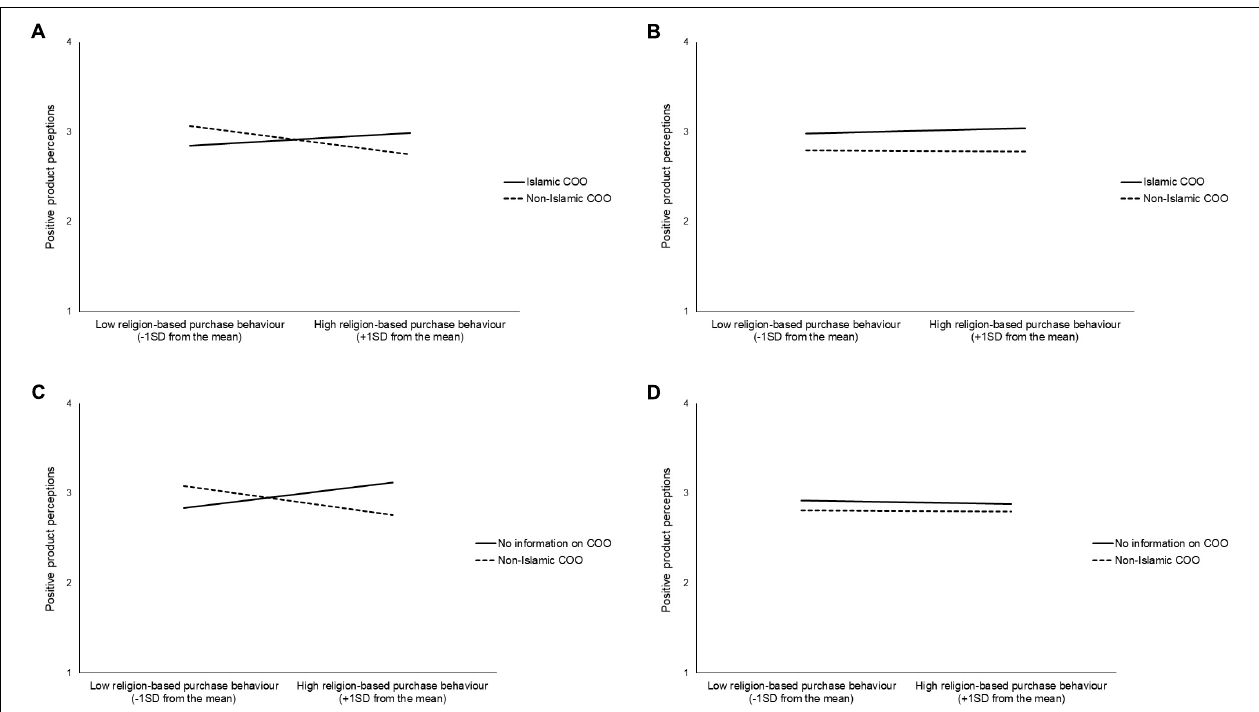
FIGURE 1 | (A) Interaction effect of the Islamic (vs. non-Islamic) COO condition and religion-based purchase behavior on positive product perceptions among those in the halal condition. (B) Interaction effect of the Islamic (vs. non-Islamic) COO condition and religion-based purchase behavior on positive product perceptions among those in the non-halal condition. (C) Interaction effect of no information on the COO (vs. non-Islamic COO) condition and religion-based purchase behavior on positive product perceptions among those in the halal condition. (D) Interaction effect of no information on the COO (vs. non-Islamic COO) condition and religion-based purchase behavior on positive product perceptions among those in the non-halal